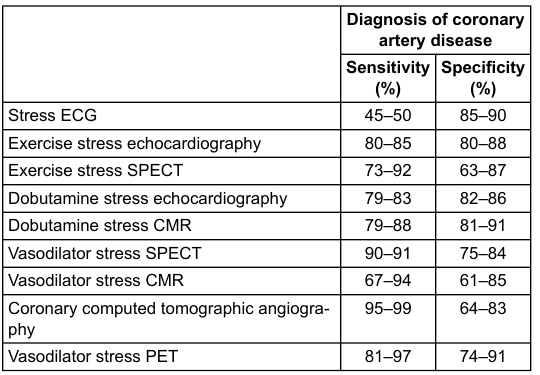
Table 1: Diagnostic accuracies of noninvasive tests (based on